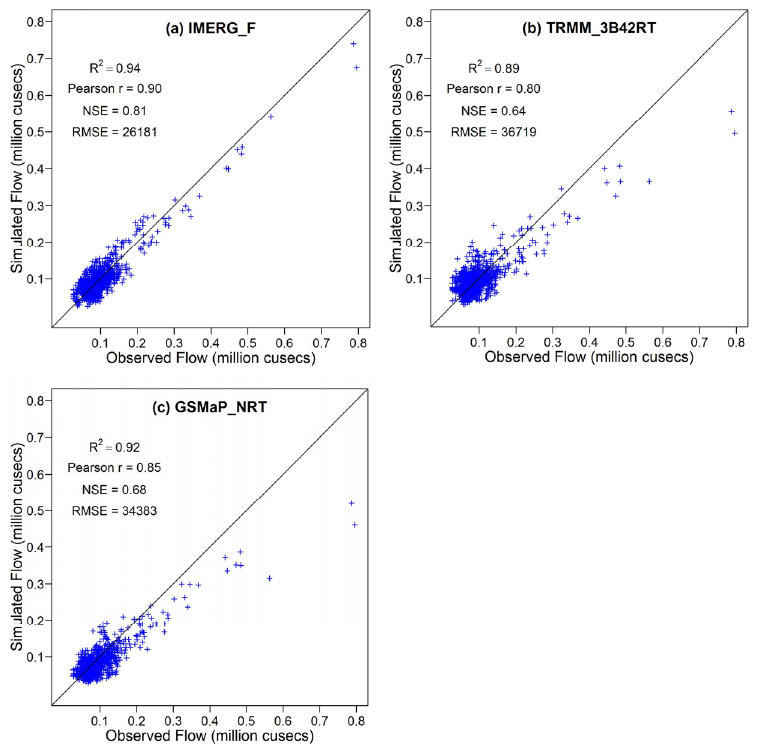
Figure 4. ( a – c ) Statistical comparison of simulated and observed flows at the Marala barrage for calibration, validation, and application periods: ( a ) IMERG-F, ( b ) TRMM_3B42RT, and ( c ) GSMaP_NRT.